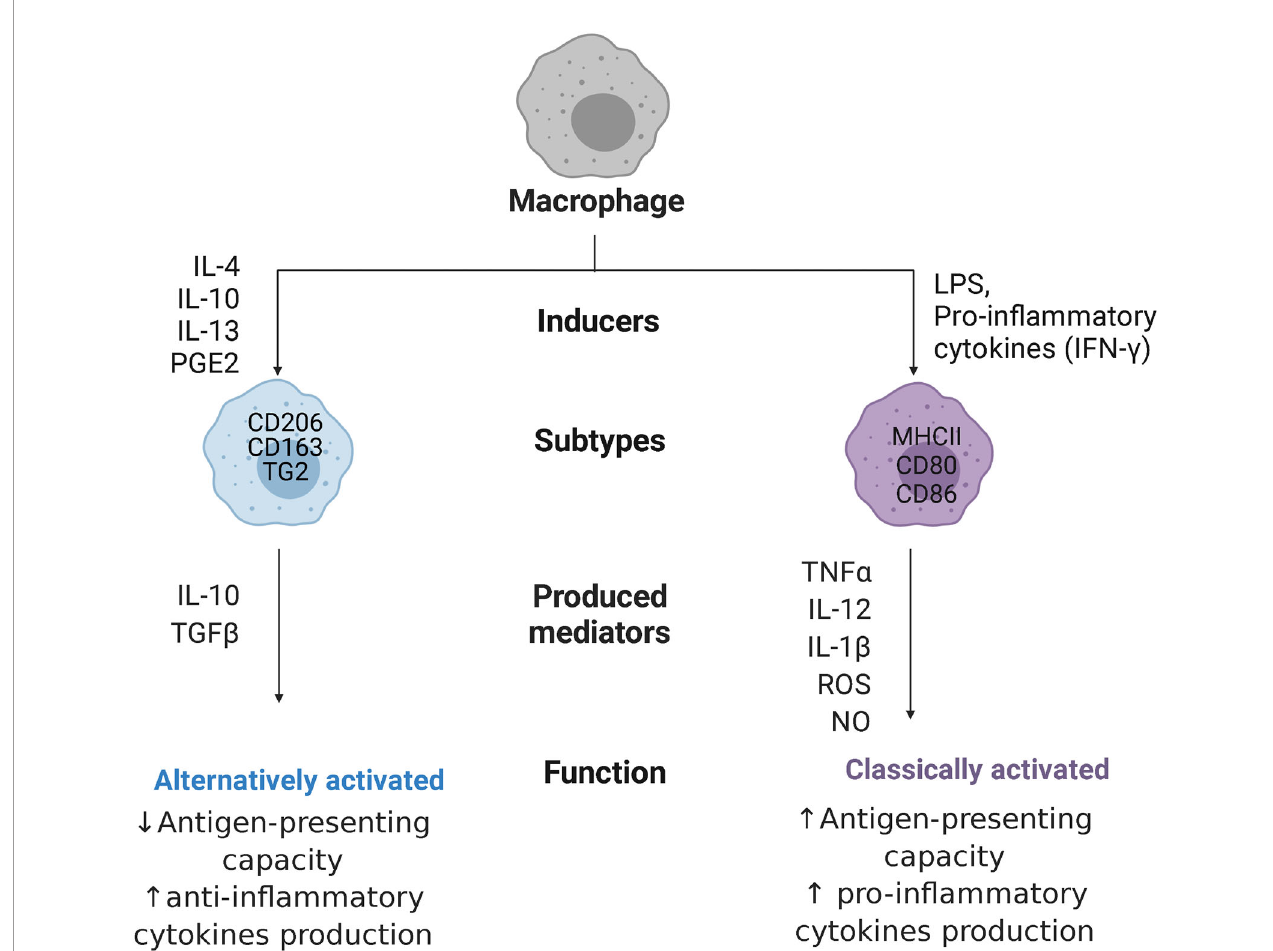
FIGURE 2 | Macrophage polarization. Macrophages can polarize to classically activated macrophages, when stimulated with pro-in fl ammatory cytokines like interferon- ƴ (IFN- ƴ ) or with bacterial products (LPS, lipopolysaccharides), or alternatively activated macrophages, when stimulated with interleukins 4,10, 13 (IL-4/10/ 13), or prostaglandin E2 (PGE2). Classically activated macrophages express major histocompatibility complex class II (MHC II) proteins and co-stimulatory molecules CD80 and CD86, while alternatively activated macrophages are characterized by high expression of mannose receptors CD206, high-af fi nity scavenger receptors CD163, and transglutaminase 2 (TG2). These cells produce, respectively, pro-in fl ammatory cytokines like tumor necrosis factor- a (TNF- a ), IL-12, IL-1 b , and IL-23 together with reactive oxygen species (ROS) and nitric oxide (NO) or anti-in fl ammatory cytokines like transforming growth factor b (TGF b ), and IL-10, with opposite capacity in presenting